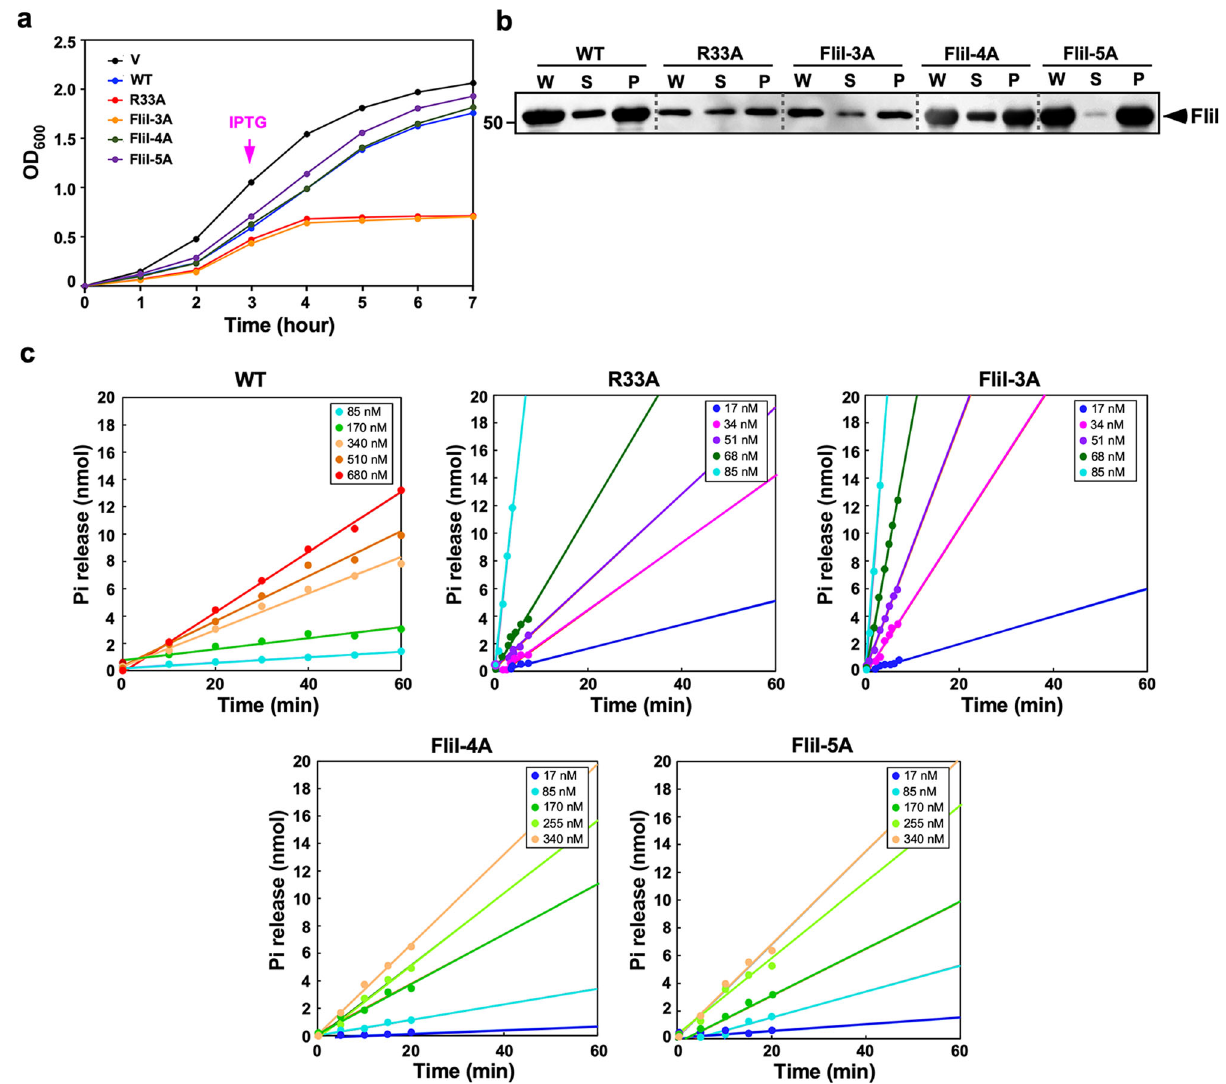
Fig. 4 Multicopy effect of FliI mutant proteins on cell growth. a Growth curve of MKM30 ( Δ fl iI ) cells transformed with pTrc99A (V), pMM1702 (WT), pMM1702(R33A) [pTrc99A/His-FliI(R33A), indicated as R33A], pMM1702-3A [pTrc99A/His-FliI(R26A/R27A/R33A), indicated as FliI-3A], pMM1702- 4A [pTrc99A/His-FliI(R26A/R27A/R33A/R76A), indicated as FliI-4A], or pMM1702-5A [pTrc99A/His-FliI(R26A/R27A/R33A/R76A/R93A), indicated as FliI-5A]. Cells were grown in L-broth containing ampicillin at 30 °C for 3 h and then IPTG was added at a fi nal concentration of 0.1 mM. The OD 600 value of each culture was monitored every hour. These data are the average of three independent biological replicates. The experimental errors are within 10%. b Effect of the fl iI(R3A) , fl iI-3A , fl iI-4A , and fl iI-5A mutations on the expression level of FliI. Immunoblotting, using polyclonal FliI antibody, of whole cellular (W), soluble (S), and insoluble (P) fractions prepared from the above transformants. The regions of interest were cropped from original immunoblots shown in Supplementary Fig. 10. c Effect of FliI mutations on dependence of the FliI ATPase activity on protein concentration. The ATPase activity of puri fi ed His-FliI (WT), His-FliI(R33A) (R33A), His-FliI(R26A/R27A/R33A) (FliI-3A), His-FliI(R26A/R27A/R33A/R76A) (FliI-4A), or His-FliI(R26A/R27A/ R33A/R76A/R93A) (FliI-5A) was measured at different protein concentrations in the presence of 4 mM ATP by using the Malachite Green assay. The activity is expressed as nmol of Pi released per min per μ g of